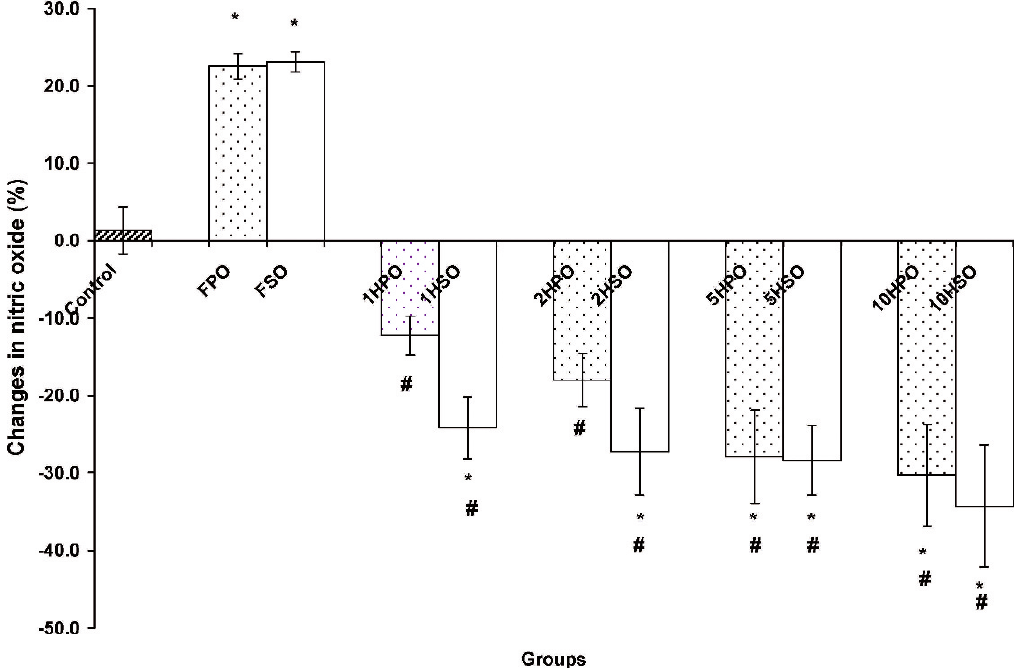
Figure 2 - Changes in plasma nitric oxide levels after 24 weeks of feeding with a basal diet (control) or chow amended with one of the following oils: fresh palm oil (FPO); palm oil that was heated once (1HPO), twice (2HPO), five times (5HPO), or ten times (10HPO); fresh soy oil (FSO); or soy oil that was heated once (1HSO), twice (2HSO), five times (5HSO), or ten times (10HSO). The results are the means ¡ SEM (n=10) . Significant difference ( p , 0.05) versus the * control or # fresh oil group. The data are expressed as percentage based on baseline values.